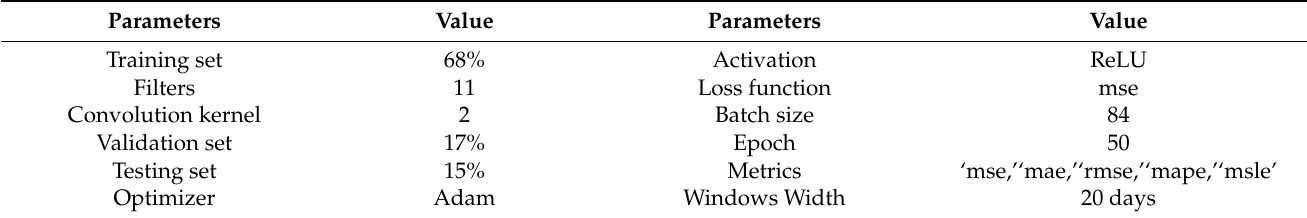
Table 6. Model hyperparameter selection.